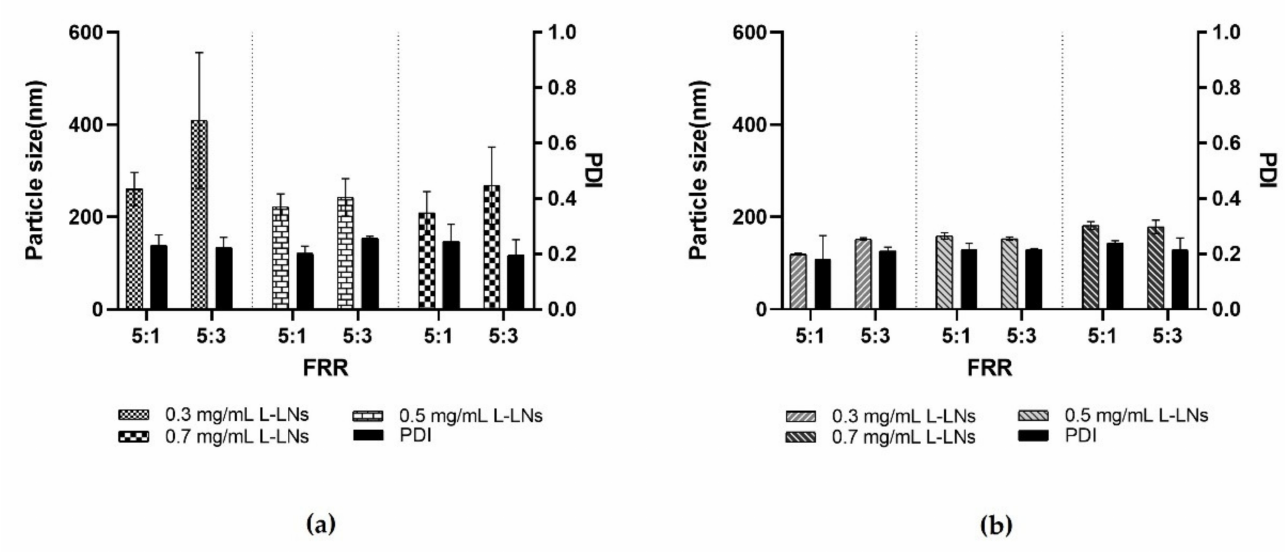
Figure 7. Resulting data in the production of L-LPs using several concentrations of lysozyme (0.3, 0.5, and 0.7 mg mL − 1 ) at both FRR 5:1 and 5:3. ( a ) Achieved data using device 1. ( b ) Achieved data using device 4. Results represent mean ± SD, n = 3 independent